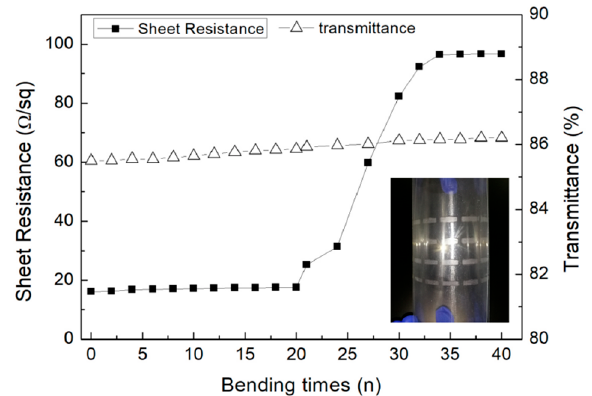
Figure 7. The relationship among the sheet resistance of the printed AgNWs patterns and transmittance with different bending cycles. The inserted photo was the way to bend the printed patterns.